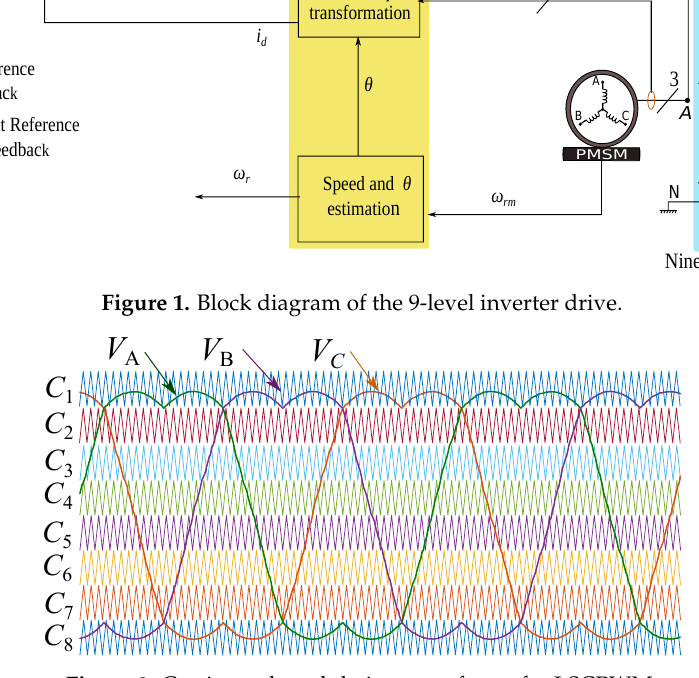
Figure 2. Carrier and modulating waveforms for LSCPWM. Table 1. Nine voltage levels and their switching